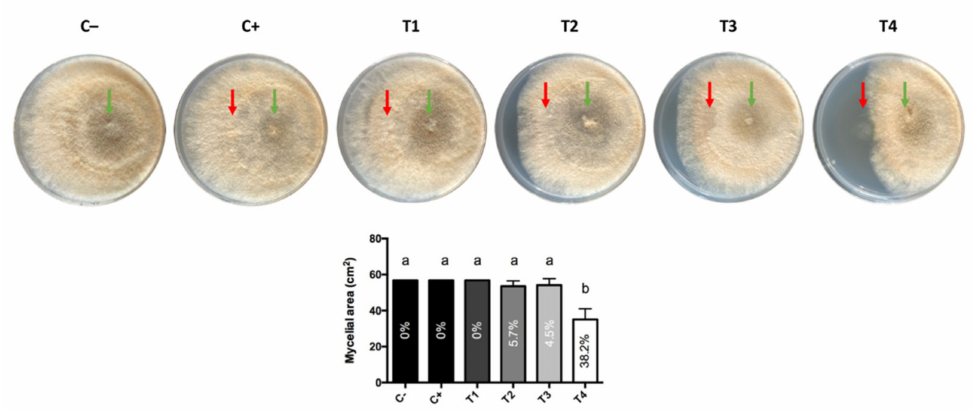
Figure 2. Effect of organic extracts (red arrows) on the mycelial growth of B. cinerea (green arrows). For B. cinerea , an inoculum of 20 µ L was used at a concentration of 1 × 10 5 conidia mL − 1 . Twenty microliters of each treatment were applied: (C − ) negative control (pathogen only), (C+) positive control (20 µ L DMSO against the pathogen), (T1) dichloromethane extract of G. cerinus , (T2) dichloromethane extract of H. osmophila , (T3) hexane extract of G. cerinus , and (T4) hexane extract of H. osmophila . The percentages inside the bars indicate the percentage of inhibition of B. cinerea mycelial growth. Vertical bars represent standard deviation, and different letters indicate significant differences according to Tukey’s test ( p < 0.05).